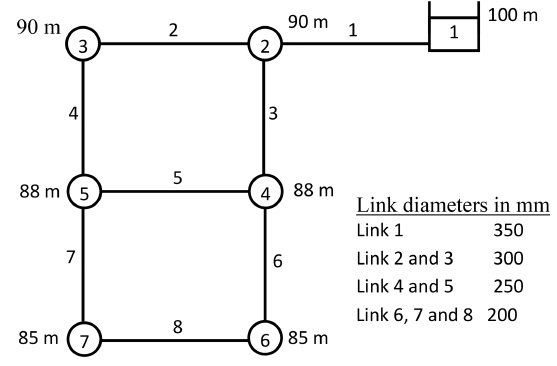
Figure 3. Layout of the two-loop network (example 1 and